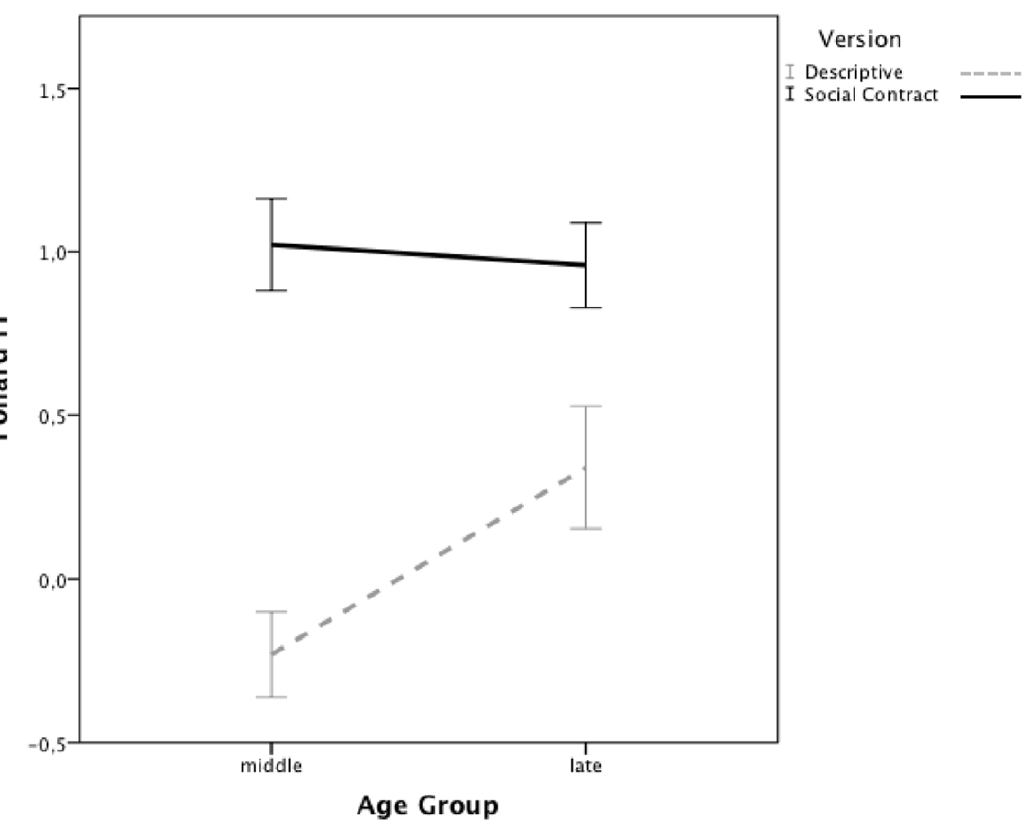
Figure 2. Mean falsification indices for the descriptive and social contract version across age groups. Error bars denote + / 2 1 standard error of the mean.